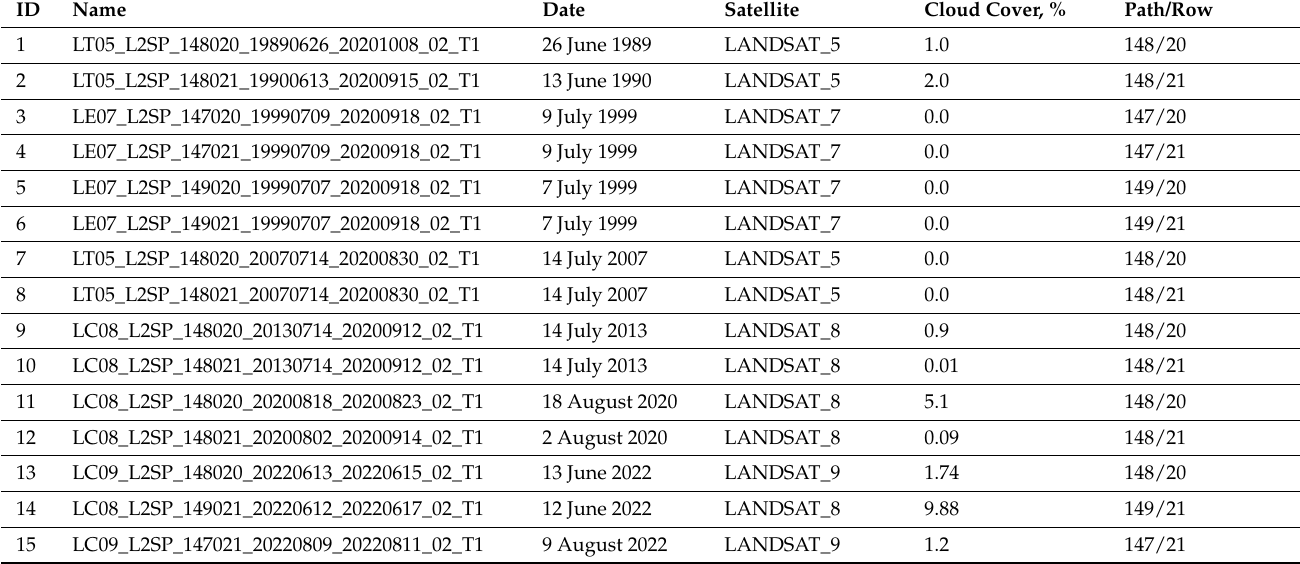
Table 2. List of satellite image.